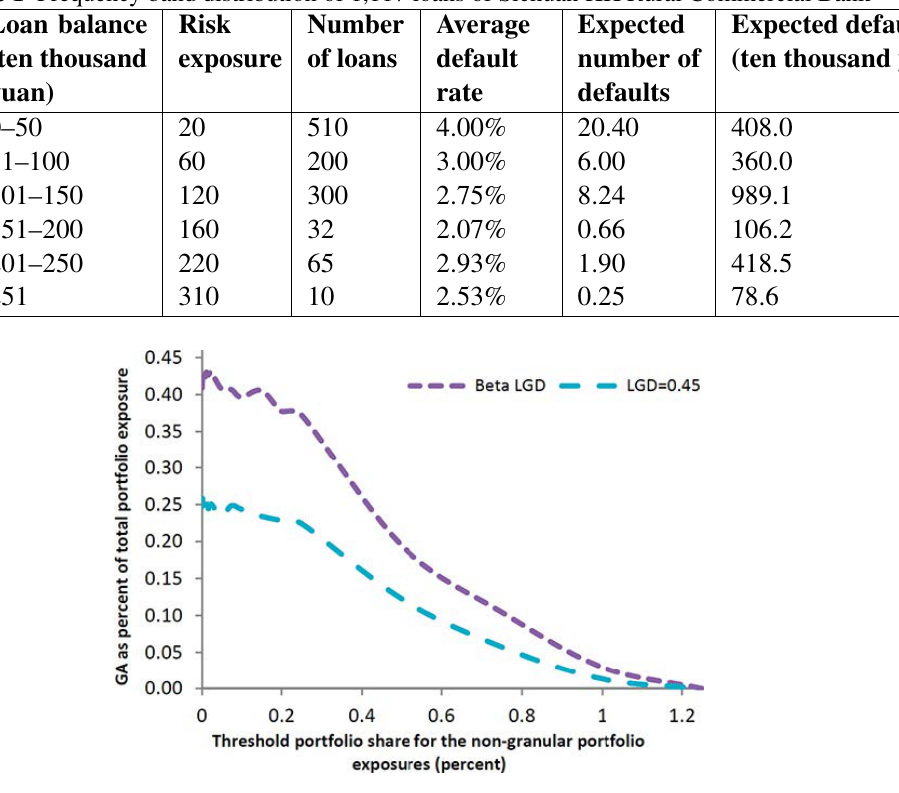
Fig. 2 Distribution of default loss of loan portfolio under α = 0.05 confidence